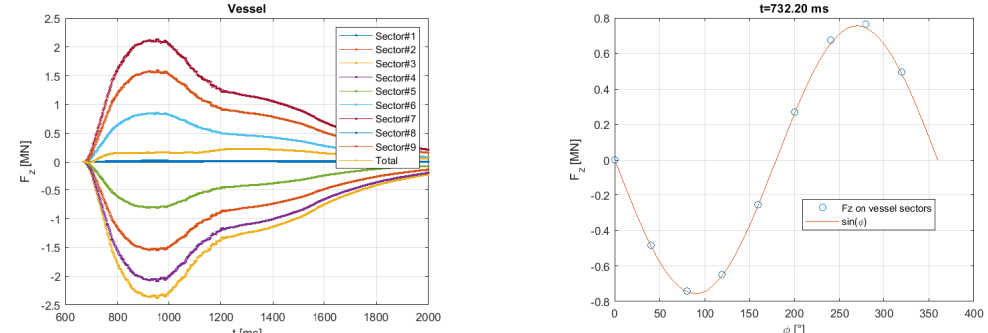
Figure 5. Force Cartesian components created in 9 sectors of the vessel itself due to interaction of the anti-symmetric halo current component in VV with external toroidal magnetic field, for the Model #1.